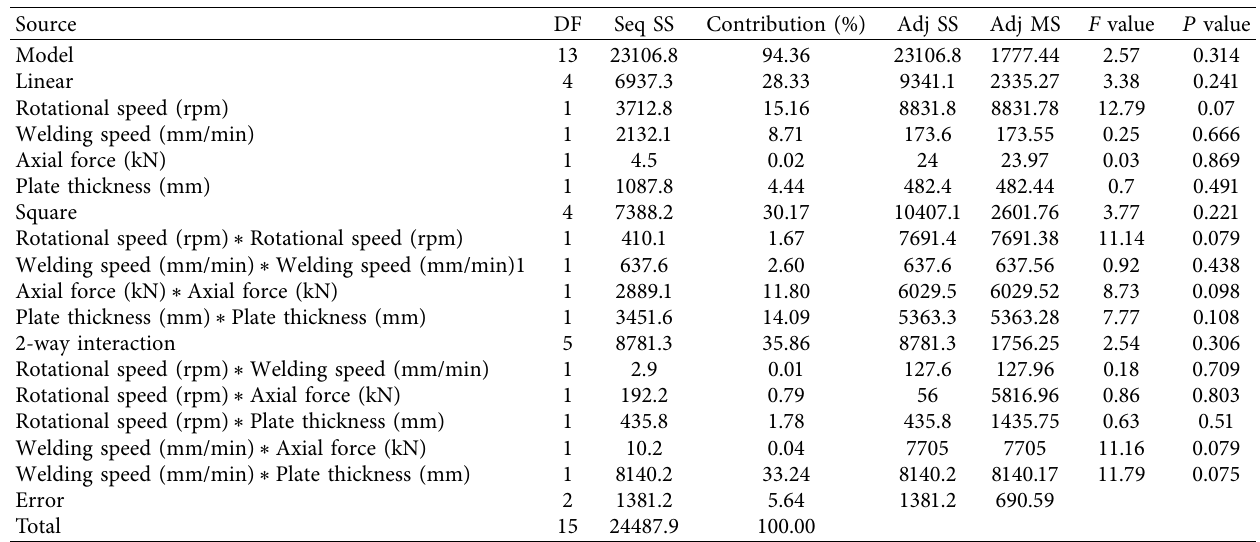
Table 4: Analysis of variance